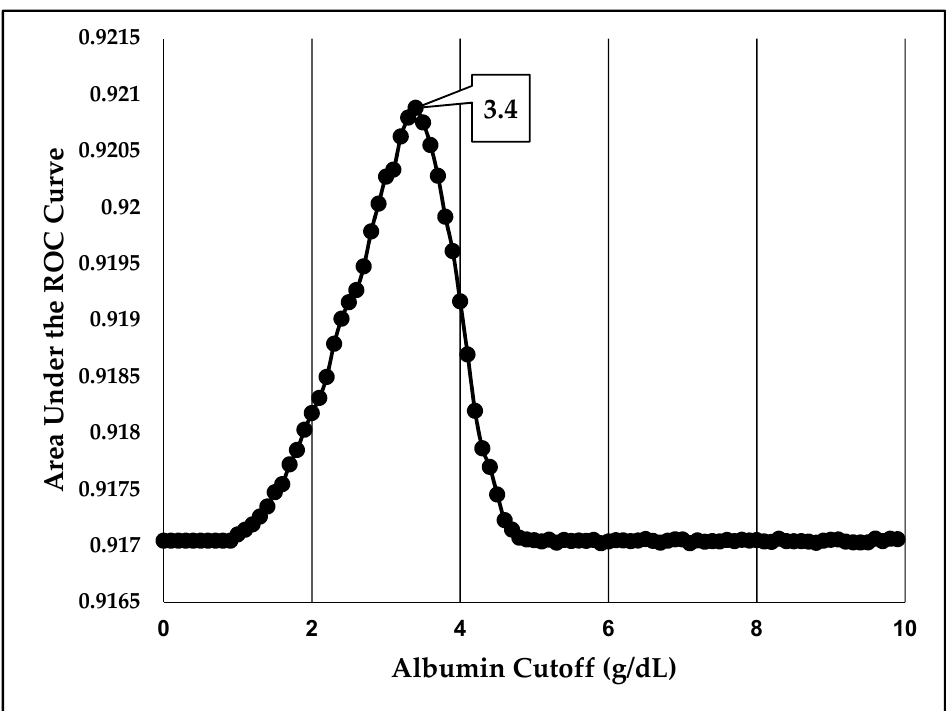
Figure 2. Optimization of preoperative serum albumin cutoff to predict death in the 30-day postoperative period—A preoperative serum albumin concentration threshold of 3.4 g/dL most optimally predicts death after multivariable adjustment. ROC—receiver operating characteristic.